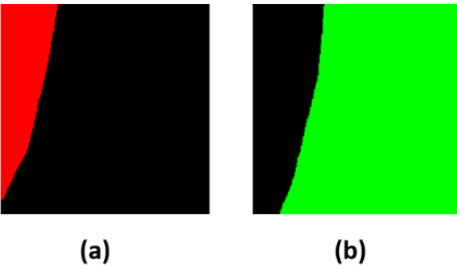
Figure 8. Large-scale objects. It shows the large-scale objects of the image. We divided the image into two large-scale objects by the road. ( a ) is service_region, which contains small-scale object service_0; ( b ) is residence_region, which contains small-scale object service_1, green_space_0, and residence_0.